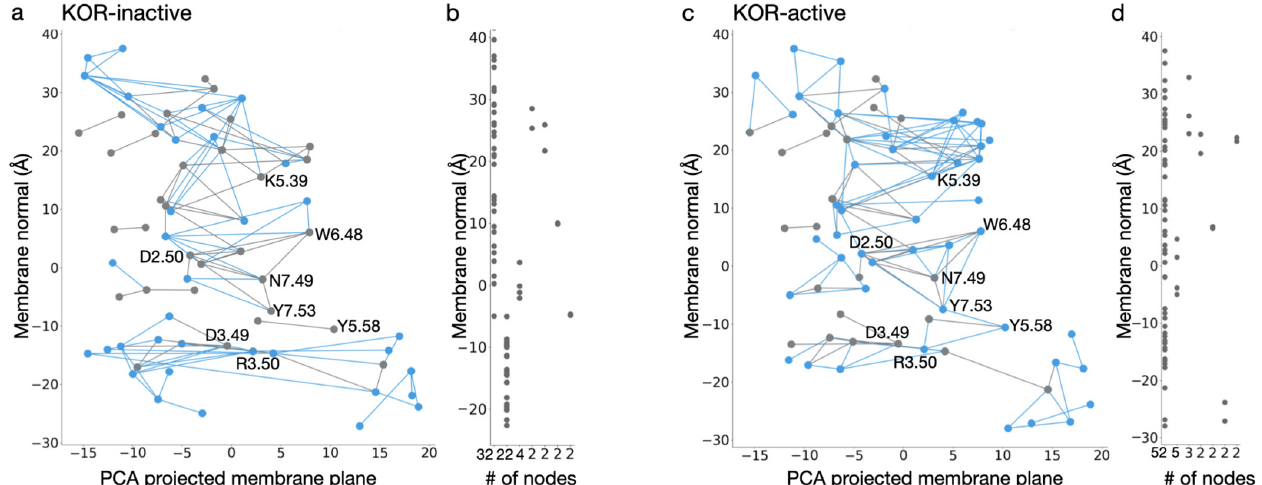
Figure 8. Comparison of water-mediated H-bond network of KOR in inactive and active conformations. ( a , c ) Water wire graph of KOR in inactive ( a ) and active ( c ) conformations. Blue lines indicate unique connections in the two structures, whereas gray edges represent H-bonds formed in both conformations of KOR. Nodes that are labeled with BW numbers are part of the conserved GPCR molecular switch motifs (shown in Figure 2a). H-bonds displayed on the graph have a minimum of 40% occupancy in the last 100 ns of the MD simulations. ( b , d ) Linear length of continuous H-bond subnetworks along the membrane normal. In the inactive conformation of KOR ( b ), the two longest chains consist of 32 and 22 interconnected protein groups, whereas in active-like KOR ( d ) there is a continuous chain, ~68Å long, composed of 52 protein groups, that connects the extracellular and intracellular side of the protein. These panels were generated based on data reported in Ref. [90].